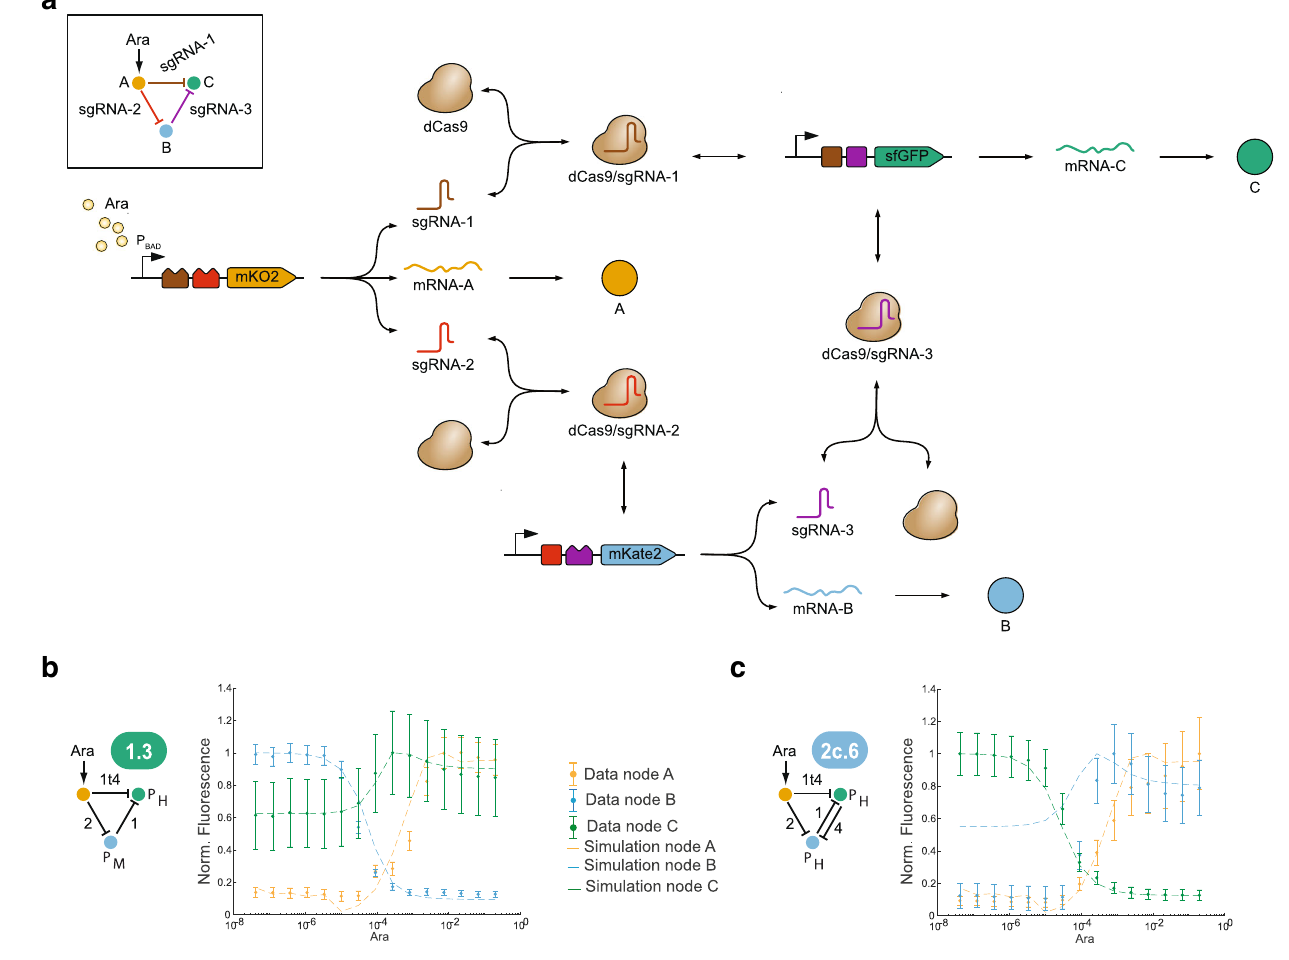
Fig. 3 | Model overview and predictions. a Model components and processes for the example of an IFFL-type 2 using generic sgRNAs 1-3 (inset). Arabinose induces expression of sgRNA-1 (brown jagged rectangle), sgRNA-2 (red) and A (orange). sgRNA-1 and sgRNA-2 form complexes with dCas (brown), and A undergoes translation (mRNA-A)and maturation (A).sgRNA-3(purple),B(blue)and C (green) are constitutively expressed (bent arrows). sgRNA-3 forms a complex with dCas, and B and C are translated (mRNA-B, mRNA-C) and mature (B,C). sgRNA/dCas